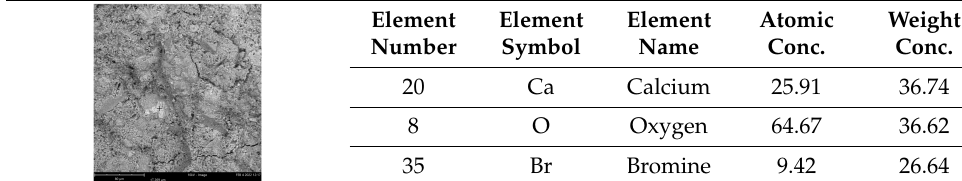
Table 13. SEM-EDS result for Y 1 concrete sample spot 2.